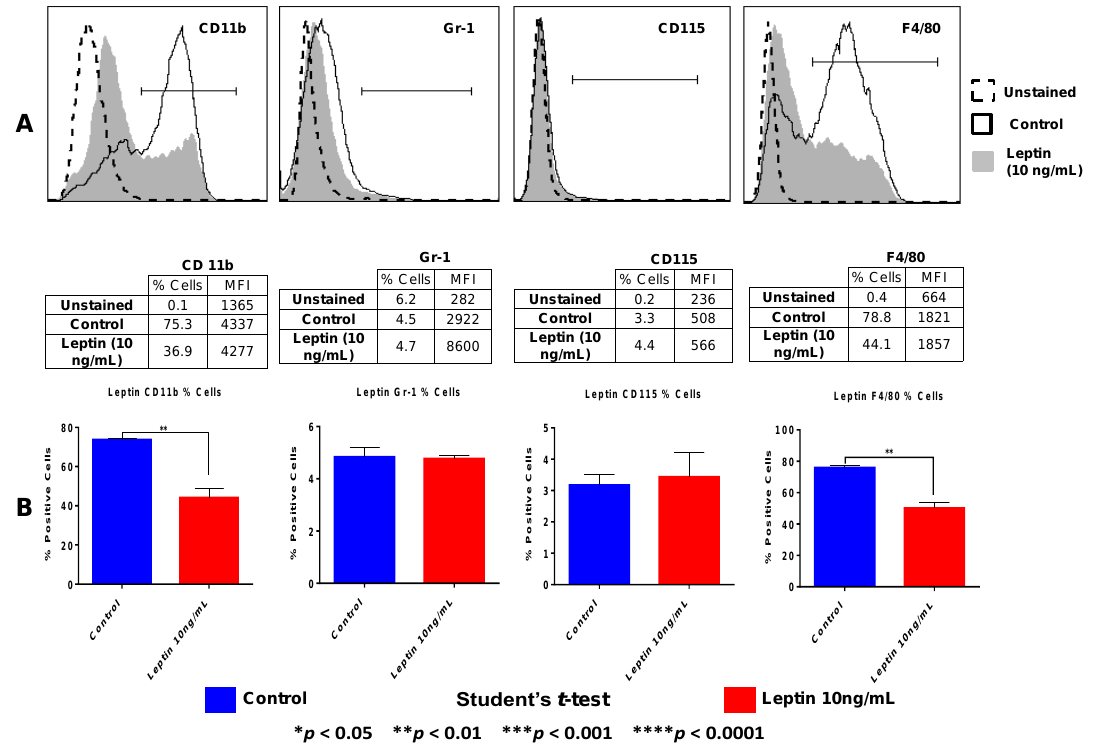
Figure 7. Leptin impairs expression of myeloid differentiation markers in macrophages. ( A ) Flow cytometric analysis of CD11b, F4/80, CD115 and Gr-1 expression in resting N-PEMs pre- treated with leptin at 10 ng/mL for 20 h shows that macrophages exposed to leptin downregulate the percentage of cells that express F4/80 and CD11b. Unstained macrophages were compared with untreated (control) and leptin-treated macrophages stained with the antibodies for those markers. Flow cytometry results were analyzed using Flow Jo software; percentages (%) of cells expressing the respective markers as well